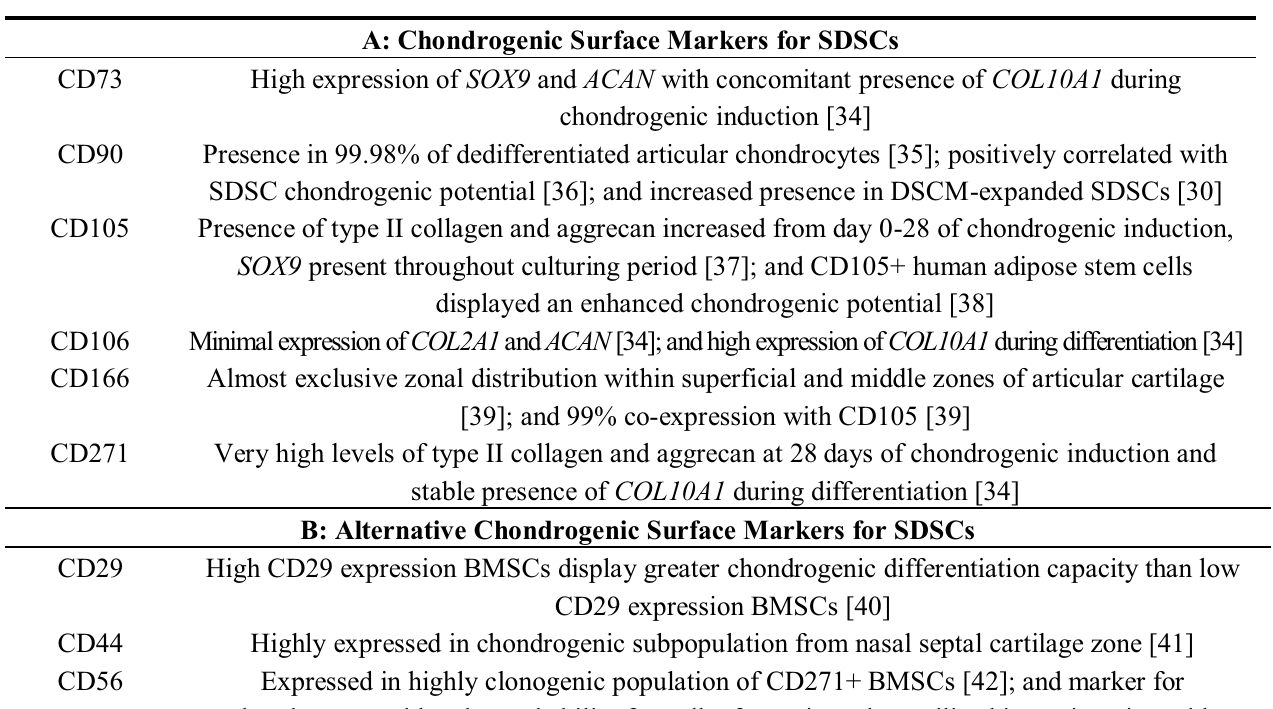
Table 2. A summary of potential chondrogenic surface markers for